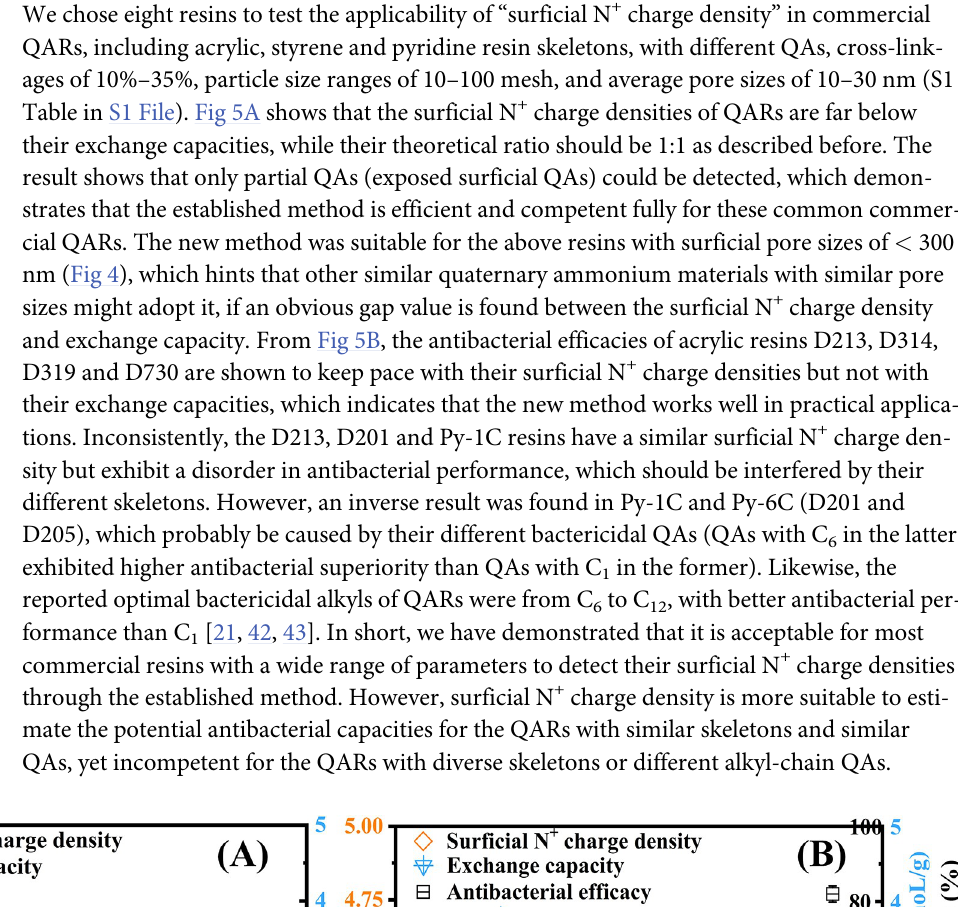
PLOS ONE | https://doi.org/10.1371/journal.pone.0239941 September 30,